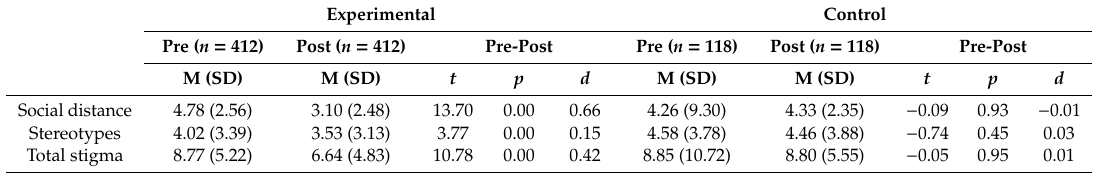
Table 2. Mean scores, standard deviations, and t test at pre- and post-intervention. Experimental Control Pre ( n = 412) Post ( n = 412) Pre-Post Pre ( n = 118) Post ( n = 118) Pre-Post